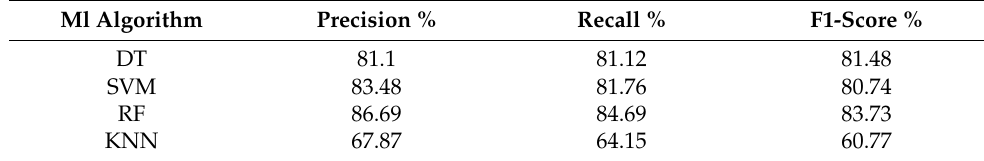
Table 4. Performance of the unigram stacked autoencoder.